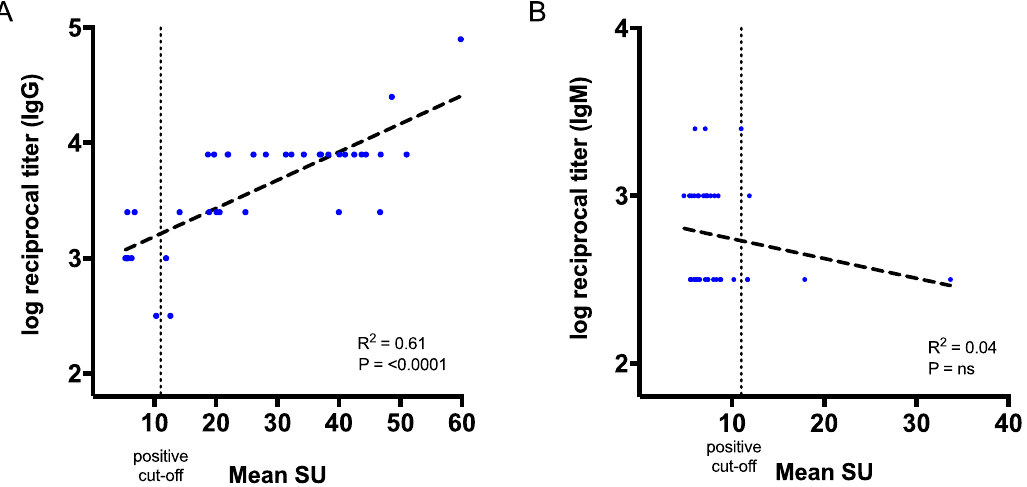
Figure 6. Correlation between the endpoint titres from in-house ELISA assay and mean standard unit (SU) from the commercial CHIKV kit. ( A ) Correlation between the in-house IgG endpoint titres and the commercial IgG mean SU. ( B ) Correlation between the IgM endpoint titres and the commercial IgM mean SU. The p values and R 2 values reflect Pearson correlation tests. A positive cut-o ff is defined as > 11